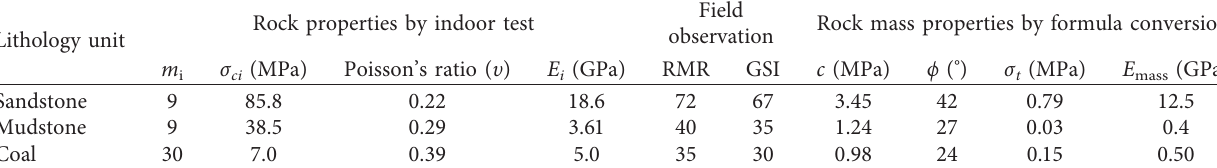
Table 2: Coal measure rock mass properties.